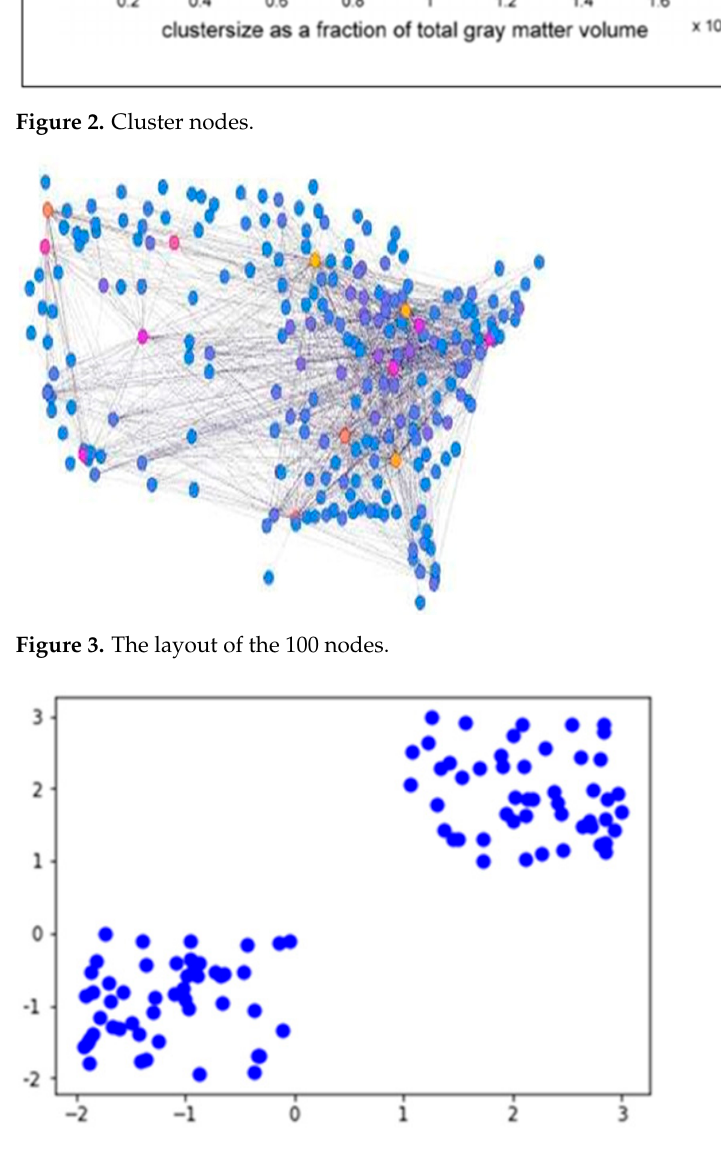
Figure 5. Centroids of the cluster . 3.1. Approaches for Searching Strategies